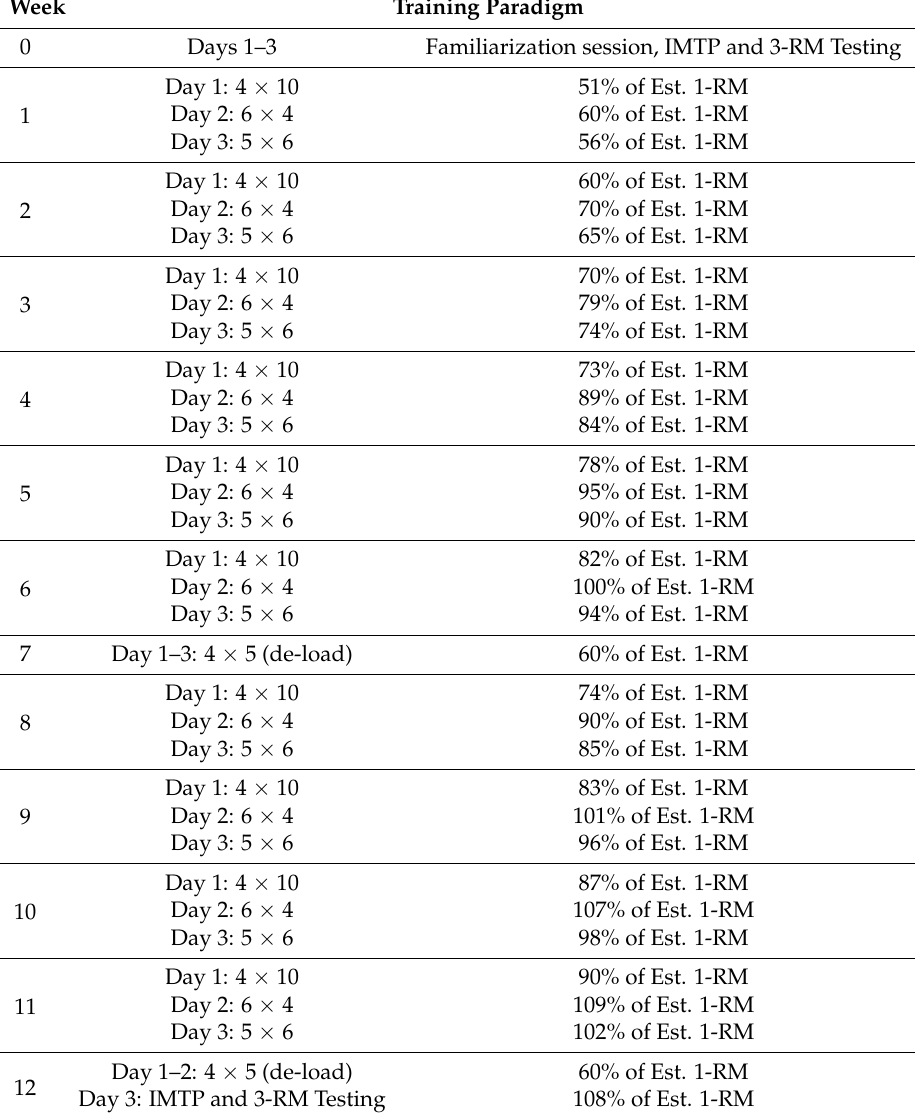
Table 1. Training load